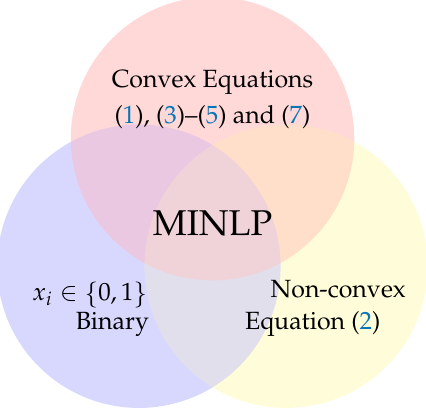
Figure 1. Characterization of the optimization